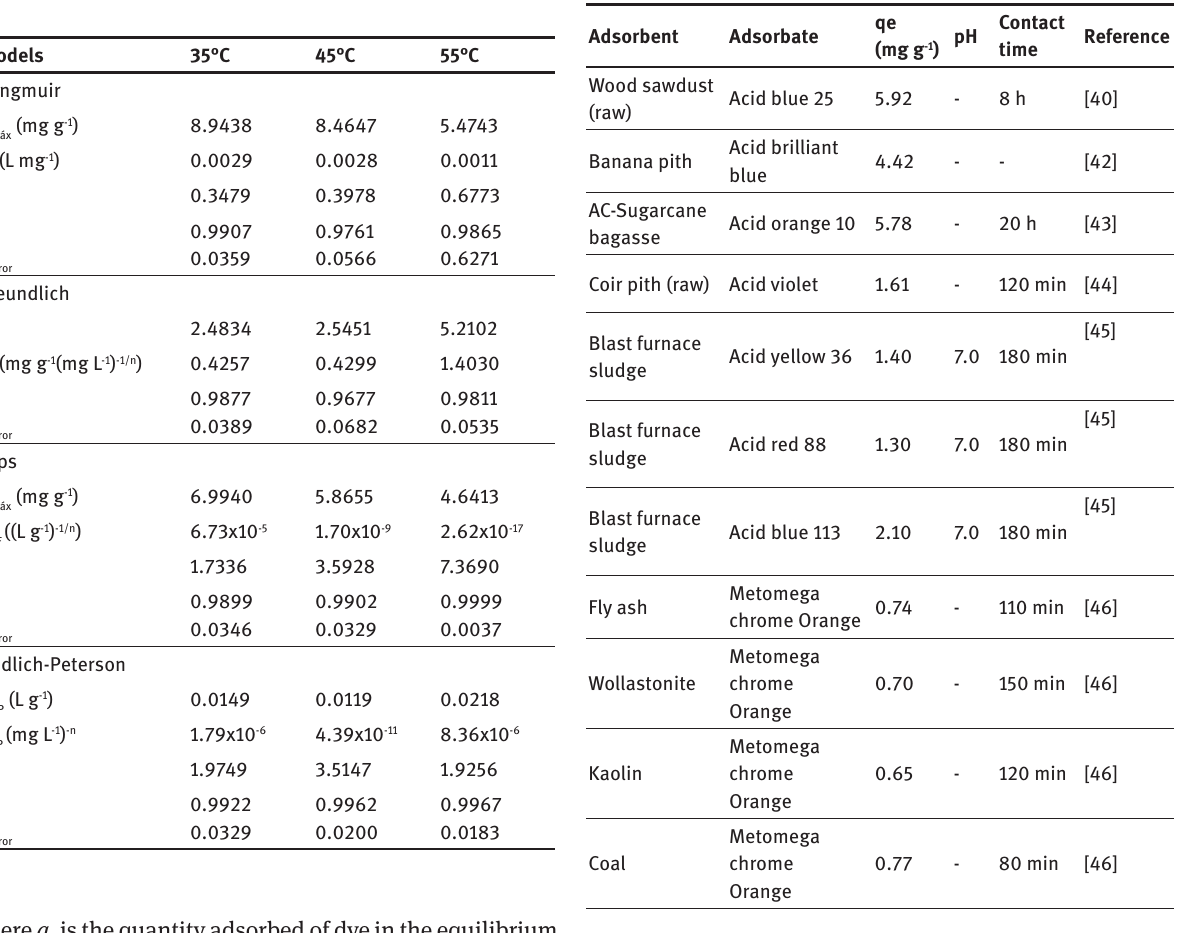
Table 3: Comparison of adsorption capacities of the anionic dyes by some